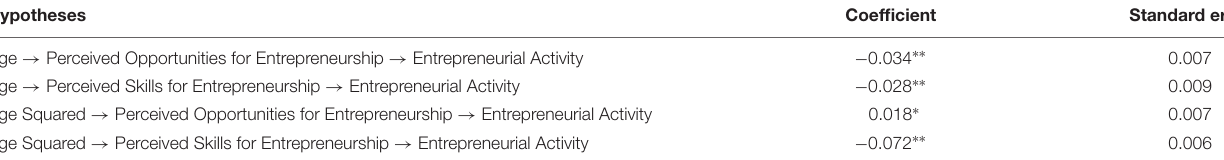
TABLE 3 | Standardized indirect effects of age and age squared on entrepreneurial activity.